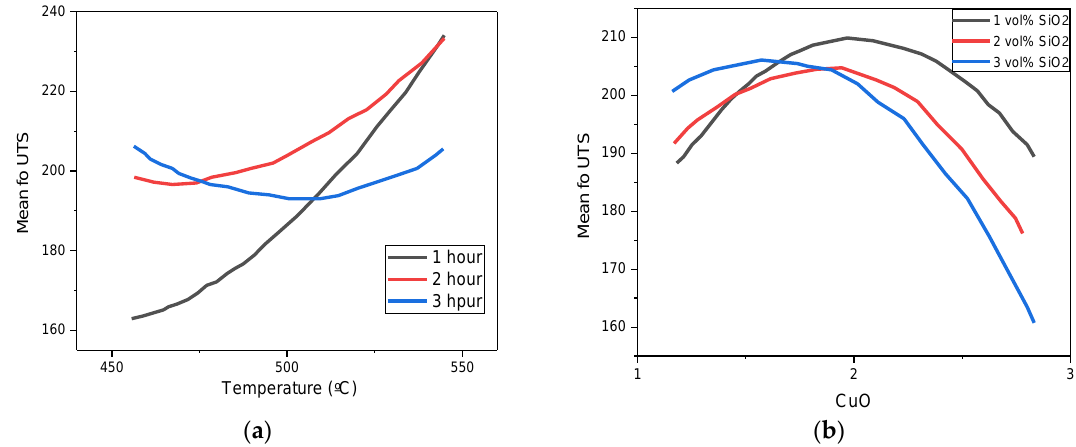
Figure 7. Interaction plot for UTS ( a ) Temperature vs Time; ( b ) CuO vs SiO 2 A very similar trend was observed in the interaction plot. The model selected